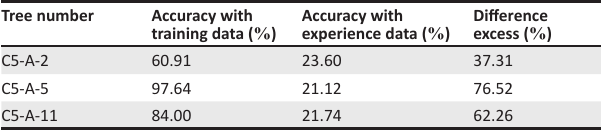
TABLE 5: Test accuracy of trees with ‘performance assessment’ target variable. Tree number